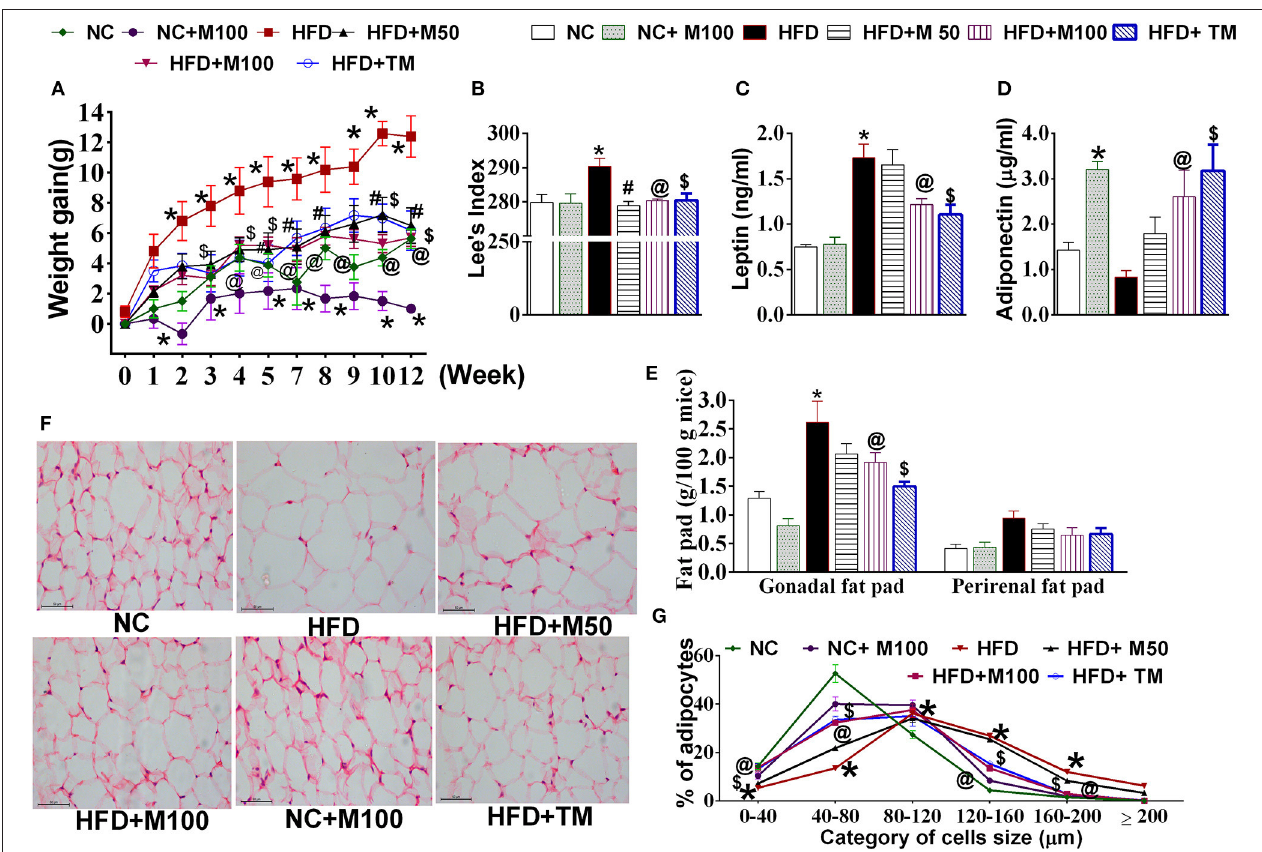
FIGURE 2 | Effect of chronic oral and topical administration of menthol against HFD feeding in mice. (A) Weekly change in body weight; (B) Lees’s index; (C) serum leptin levels (using ELISA); (D) serum adiponectin levels (using ELISA); (E) visceral adipose tissue weight; (F) representative image of H&E stained sections of mouse gonadal fat tissue; and (G) frequency distribution analysis of adipocyte cell size in H&E stained sections of mouse gonadal fat tissue. NC, normal rodent chow fed; HFD, high fat diet fed; HFD + M50, HFD fed plus daily administration of 50 mg/kg menthol ( p.o. ); HFD + M100, HFD fed plus daily administration of 100 mg/kg menthol ( p.o. ); NC + M100, NC fed plus daily administration of 100 mg/kg menthol ( p.o. ); HFD + TM, HFD fed plus daily application of 10% topical menthol. n = 5. All the values are expressed as mean ± S.E.M; Analysis was carried out by RM ANOVA (A,G) or by one way ANOVA followed by Tukey’s multiple comparison (B–E) ; * p < 0.05 HFD and NC + M100 vs. NC; # p < 0.05 HFD + M50 vs. HFD fed group; @ p < 0.05 HFD + M100 vs. HFD fed group; $ p < 0.05 TM vs. HFD fed